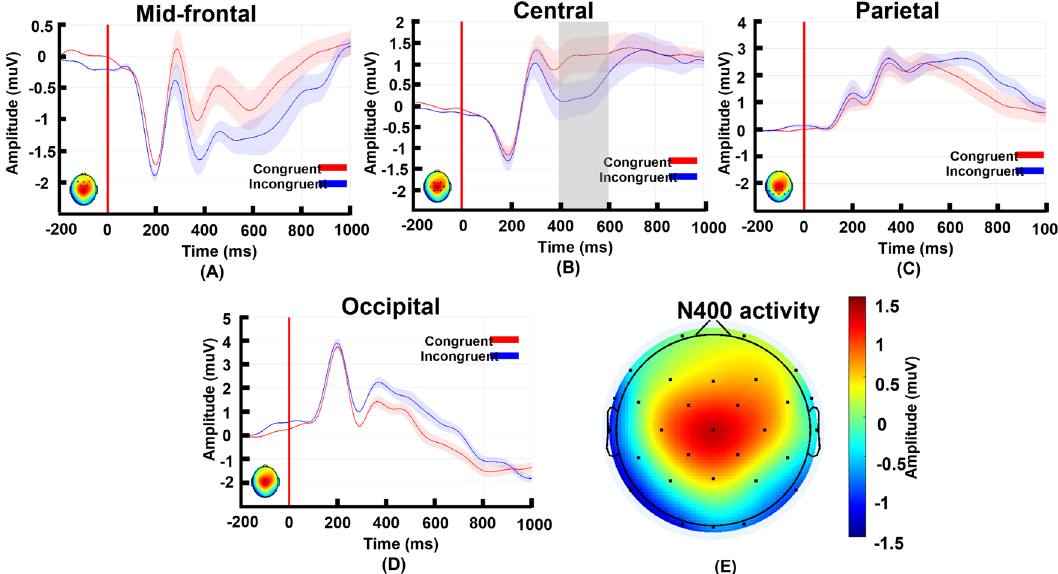
Figure 1. ERP obtained from average on trials of each condition and specific regions, and topo-map of N400 activity. Panels ( a ) to ( e ) show ERP activity for frontal, central, parietal, and occipital regions respectively. In all panels from ( a ) to ( d ), red curves show the ERP of congruent condition, and blue curve shows ERP of incongruent condition. The shaded area around each line indicates standard deviation of signals divided by square root of number of channels. In the same panels, the vertical red line in 0 ms indicates the start of the stimuli. The small topo-map at the bottom-left of each panel shows N400 activity and indicates the selected electrodes of each region. In panel ( c ), for the central region, the area highlighted in gray shows the significant difference between congruent and incongruent conditions (p = 0.04, effect size = 0.54), that occurs in N400. Panel ( e ) shows the difference of brain activity in two conditions (congruent-incongruent) in N400 (averaged from 400 to 600 ms). The hot colors show positive activity (i.e., congruent > incongruent) and the cold colors indicate negative activity (i.e., congruent <